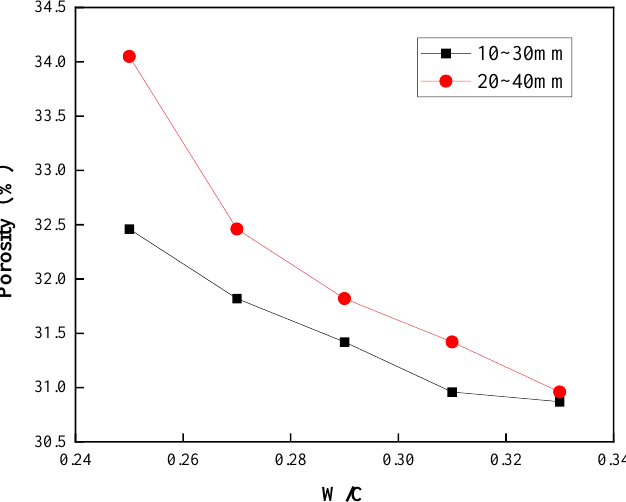
Figure 4. Effect of water–cement ratio and aggregate particle size on porosity.